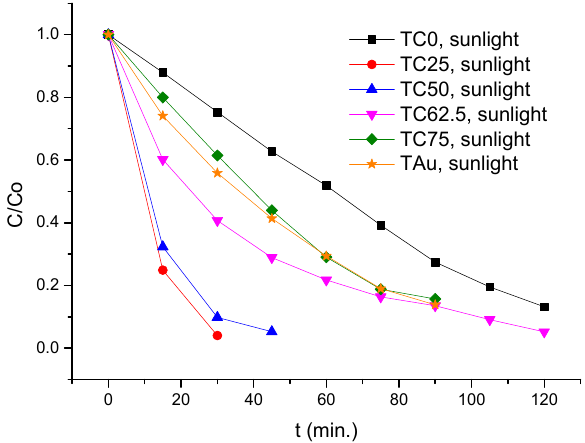
Figure 9. MO degradation rates in the presence of TAu and TC0–75 photocatalysts under sunlight irradiation.